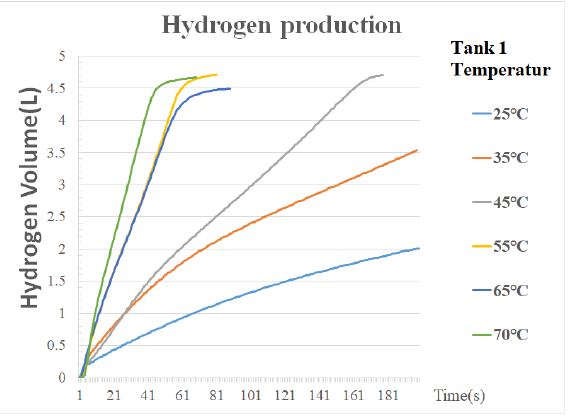
Figure 3. Comparison of the hydrogen production rates of the 45 wt% Co 2+ /Al 2 O 3 catalyst at different temperatures of catalyst bed of the primary hydrogen production tank.